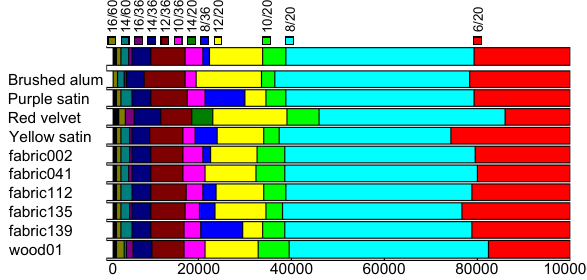
Fig. 17 Top row: The color coded optimal placement of slices in terms of e s /a s for various numbers of samples. Other rows: Stability test of optimal placement of slices: in each row, one material is left out from computation of the optimal